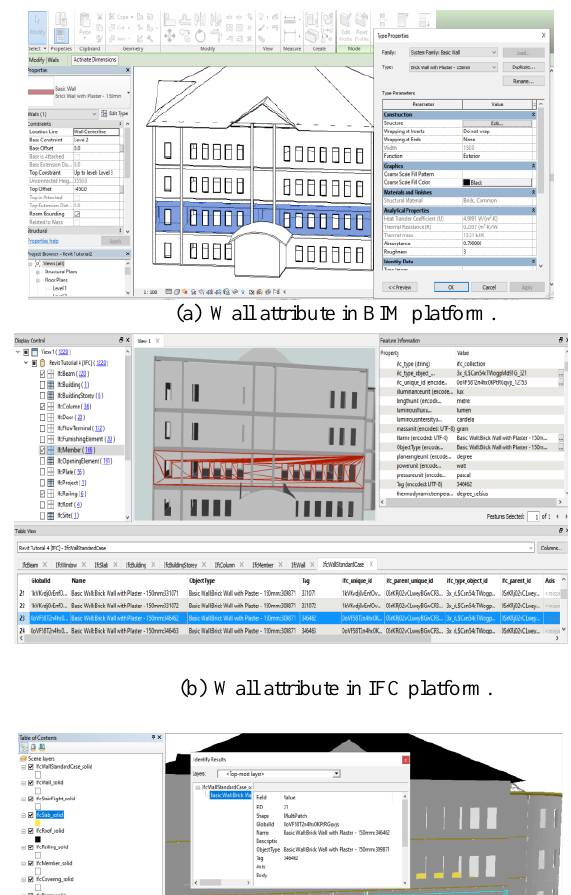
Figure 10. Comparison of data inconsistency on geometric data after conversion process from BIM into IFC. Second validation is on semantic data. There are some semantic data missing during converting BIM into IFC and GIS. In Figure 11 show the validation on semantic data after conversion process.